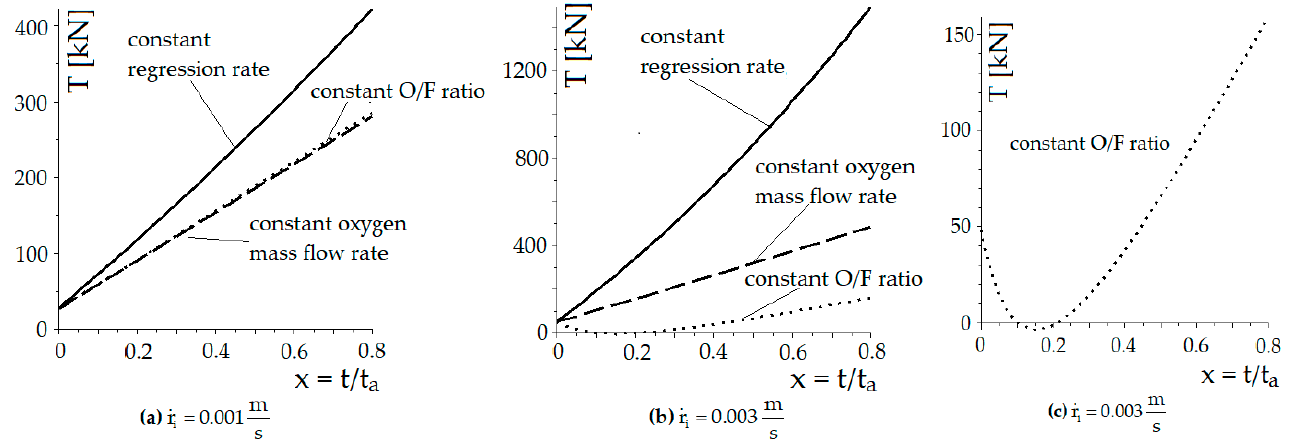
Figure 2. The excess thrust balancing the friction force. L = 15 m; R TM,i = 2.